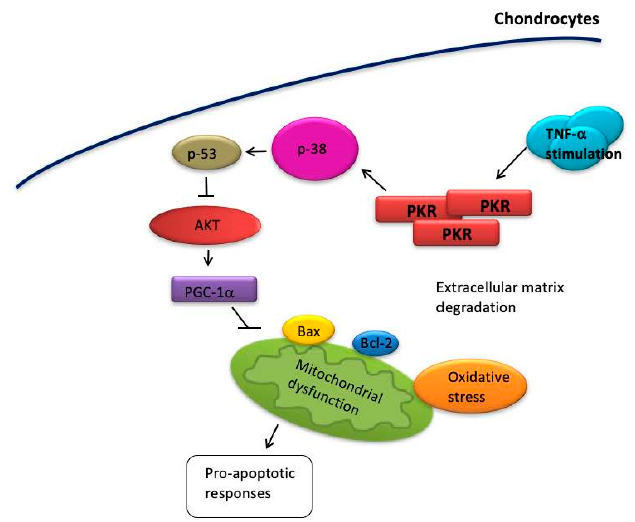
Figure 8. Phosphorylation of p38 MAPK by PKR activation elevates the expression of p53, leading to downregulation of AKT and the following suppression of PGC-1 α . Subsequently, aberrant mitochondrial biogenesis (decreased the mitochondrial DNA copy number and mass) and enhanced oxidative stress (higher ROS and lower SOD activity) correlates with higher Bax and lower Bcl-2 expression with increased caspase-3 and TUNEL-positive cells, which may contribute to the pathogenesis of OA.